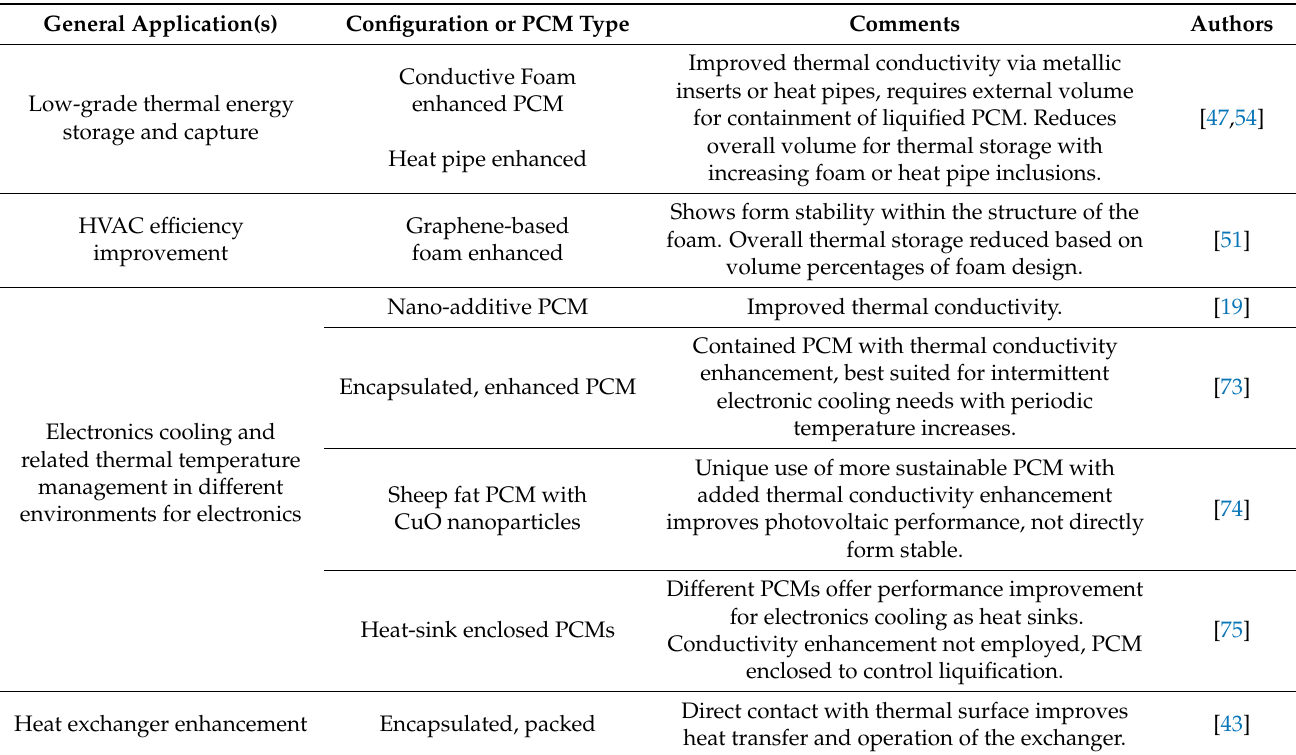
Table 2. Small-scale PCM Applications